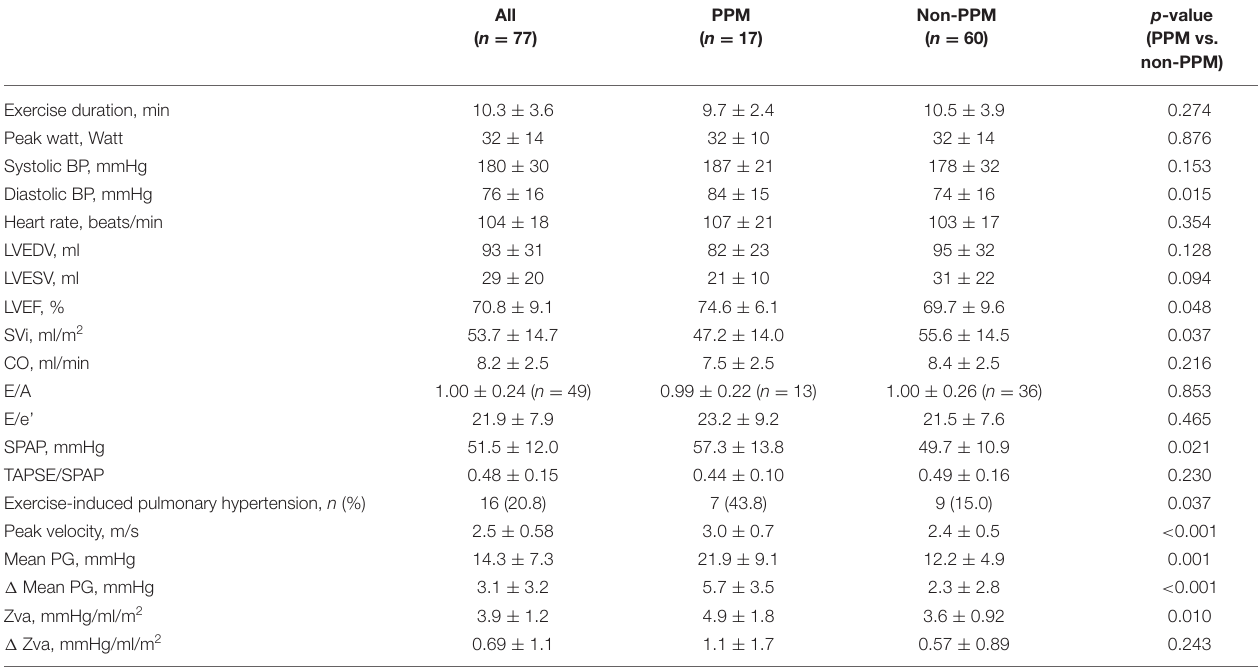
TABLE 4 | Exercise stress echocardiography data.